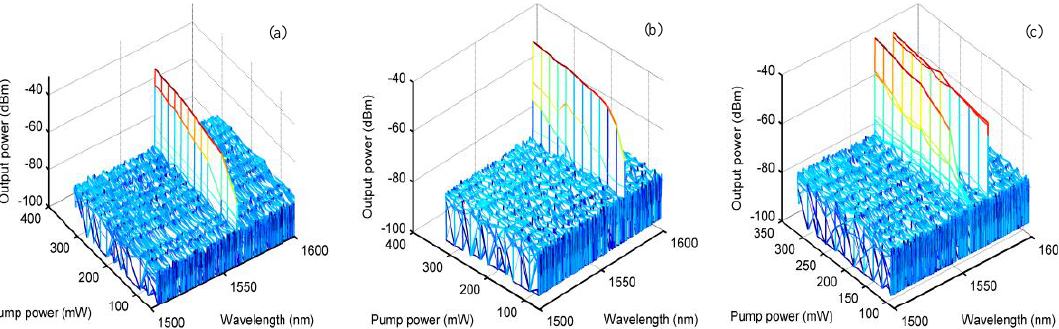
Figure 9. The output spectra of the laser under different 980-nm pump optical powers: ( a ) 1556-nm output, ( b ) 1570-nm output, and ( c ) 1556-nm and 1570-nm output.